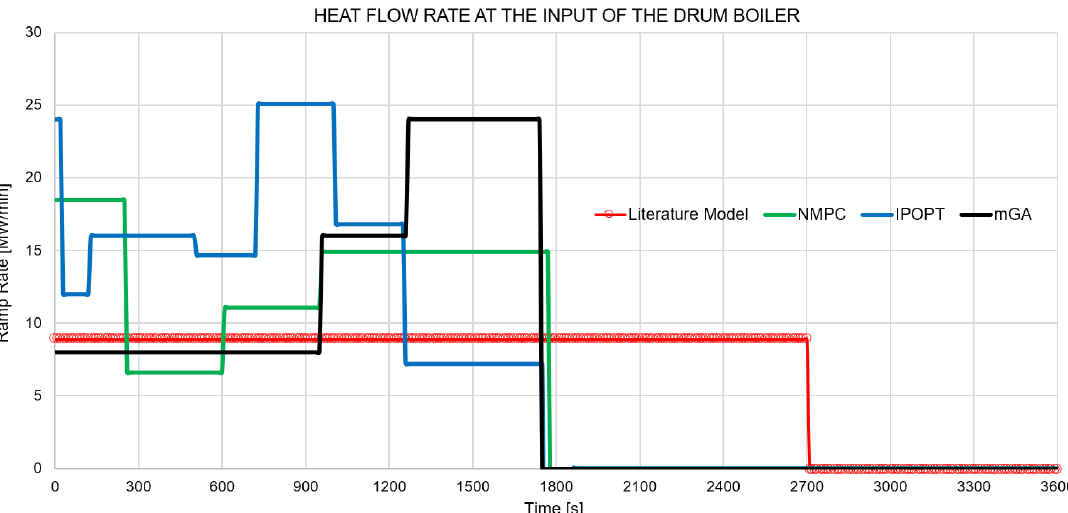
Figure 19. Results comparison between the curves of the operating reference profile available in the literature (red line), the optimized profiles reported by [17] (green line) and [20] (blue line), and the proposed approach (black line) for the heat flow supplied to the